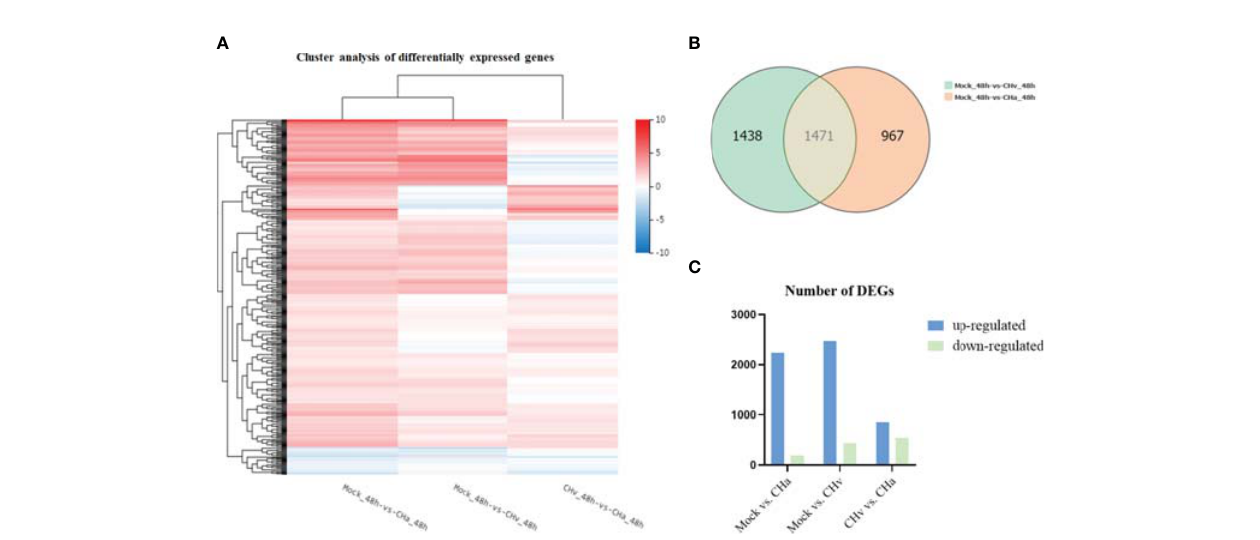
FIGURE 1 | Transcriptome data pro fi le generated by BGIseq-500 platform and differential expression analysis. (A) Heat map analysis is used to classify gene expression patterns at 48 hpi. Genes with similar expression patterns were clustered, as shown in the heat map. To intensity of the color indicates gene expression levels that were normalized according to log10 (FPKM + 1) values. Red represents high expression level genes and blue represents low expression level genes. (B) Venn diagram displaying a global view of the numbers of differentially expressed genes. The overlap of differentially expressed genes at 48hpi Mock vs. CHa and Mock vs. CHv. The numbers in the diagram indicate gene numbers and refer to each comparison. (C) Histogram showing screened differentially expressed